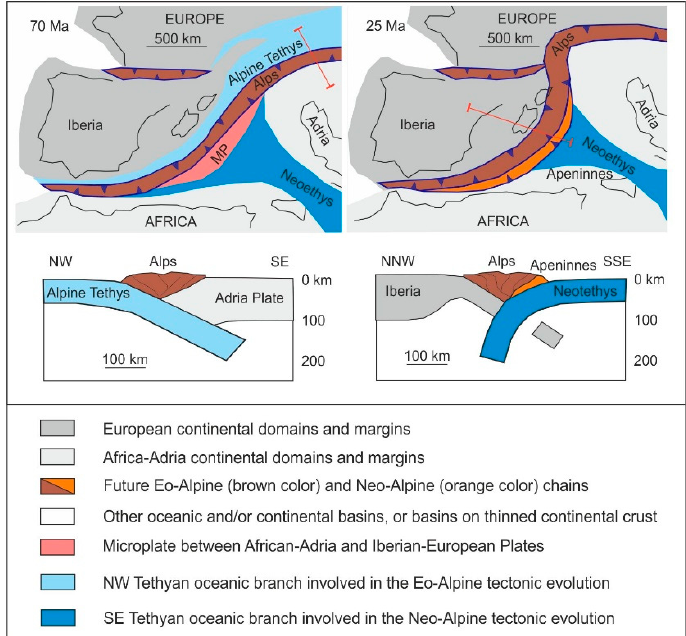
Figure 5. Reproduction of evolutionary paleogeographic and paleotectonic sketch maps of the central-western Mediterranean and schematic geological sections of the area in the latest Cretaceous (70 my) and latest Oligocene (25 my), (after [54]) and considering on the basis of previous studies (i.e., [58], [9], among others) the presence of two oceanic branches separated by a microplate located between African and European plates.